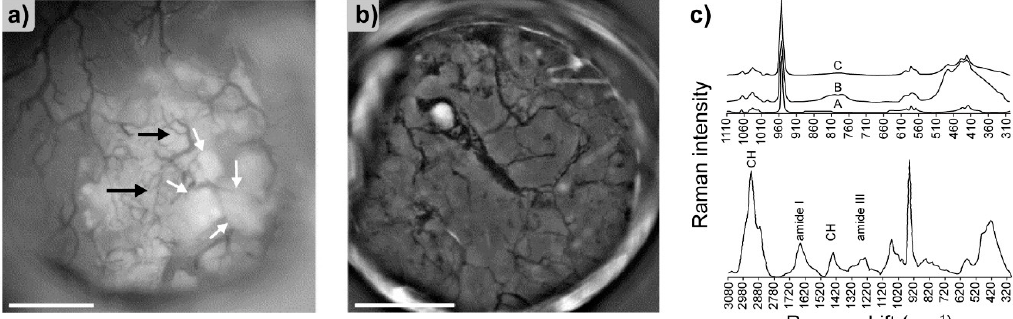
Figure 14. ( a ) Images from intravital observations of HA implanted within the calvaria, six months after surgery. Black arrows point to blood vessels within the bone and white arrows to implanted material. Scale bars correspond to 1 mm. ( b ) Eight months after surgery, the implanted β -TCP is not present. ( c ) Raman spectra of HA powder prior implantation (A), intravital hydroxyapatite spectra in rabbit calvaria after three (B), and twelve weeks (C). After implantation (top) and intravital bone two weeks after implantation (bottom). Figure adapted with permission from [94].